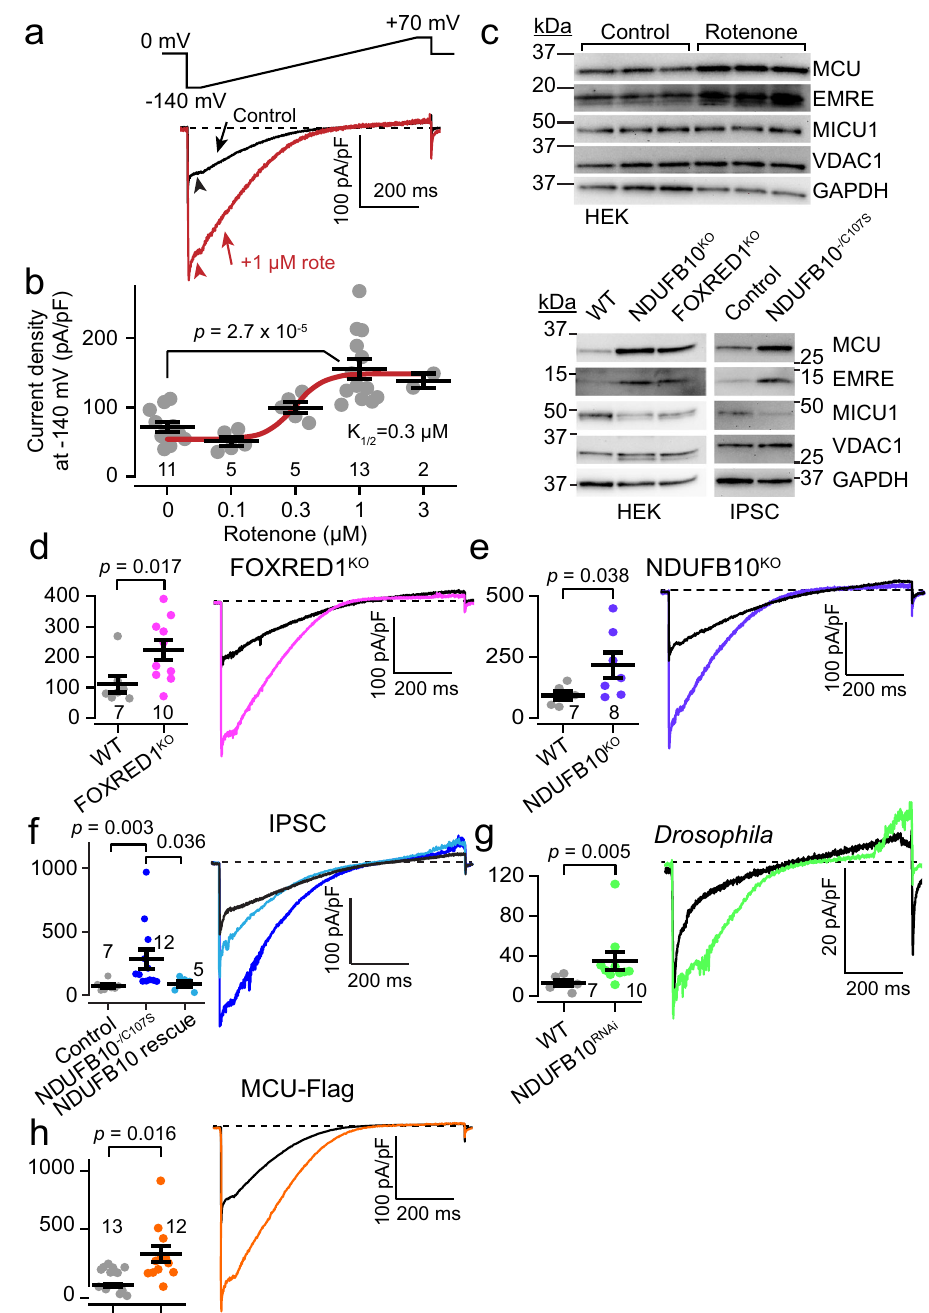
Fig. 1 Complex I dysfunction increases I MiCa . a Top, voltage ramp protocol. Bottom, Exemplar I MiCa traces are larger after chronic 1 µ M rotenone